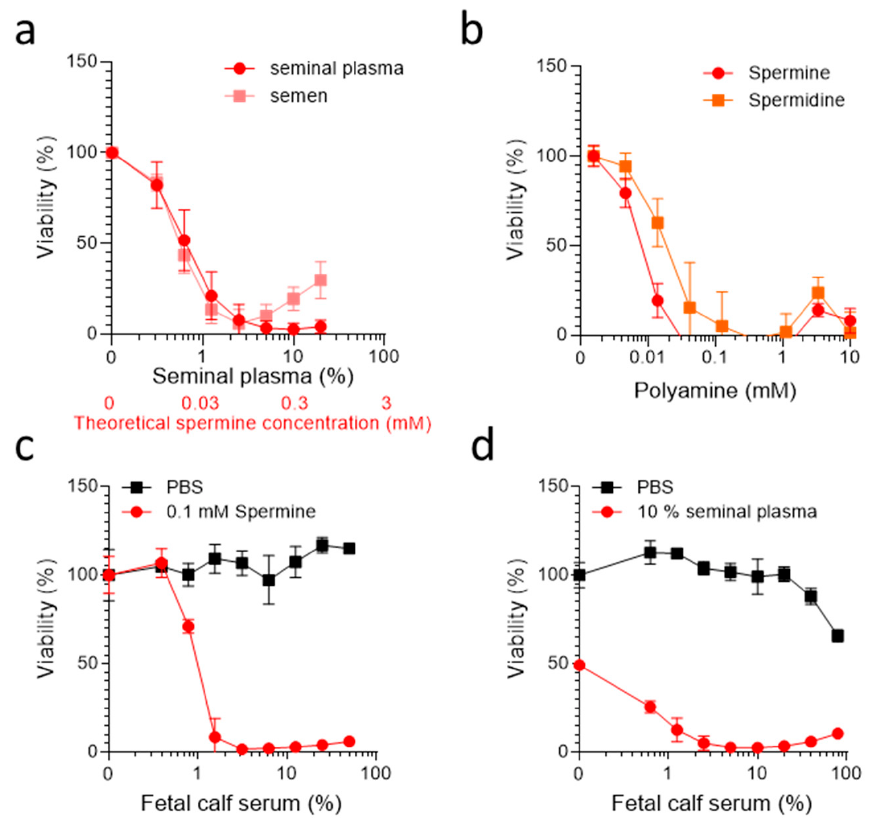
Figure 1. Semen, seminal plasma, spermine, and spermidine are cytotoxic in the presence of FCS. ( a ) The TZM-bl cells (2 × 10 3 ) were treated with serially diluted pooled seminal plasma or semen in the presence of 10% FCS. ( b ) The TZM-bl (2 × 10 3 ) cells were treated with serially diluted synthetic spermine or spermidine in the presence of 10% FCS. ( c , d ) The TZM-bl cells (2 × 10 3 ) were exposed to 0.1 mM spermine or PBS ( c ), or 10% pooled SP and PBS ( d ) in the presence of DMEM supplemented with indicated concentrations of FCS. ( a – d ) The viability was determined 2 days later by MTT assay. Data shown are average % values derived from three individual experiments ( a , b ) or one representative experiment ( c , d ) performed in biological triplicates ± SD.